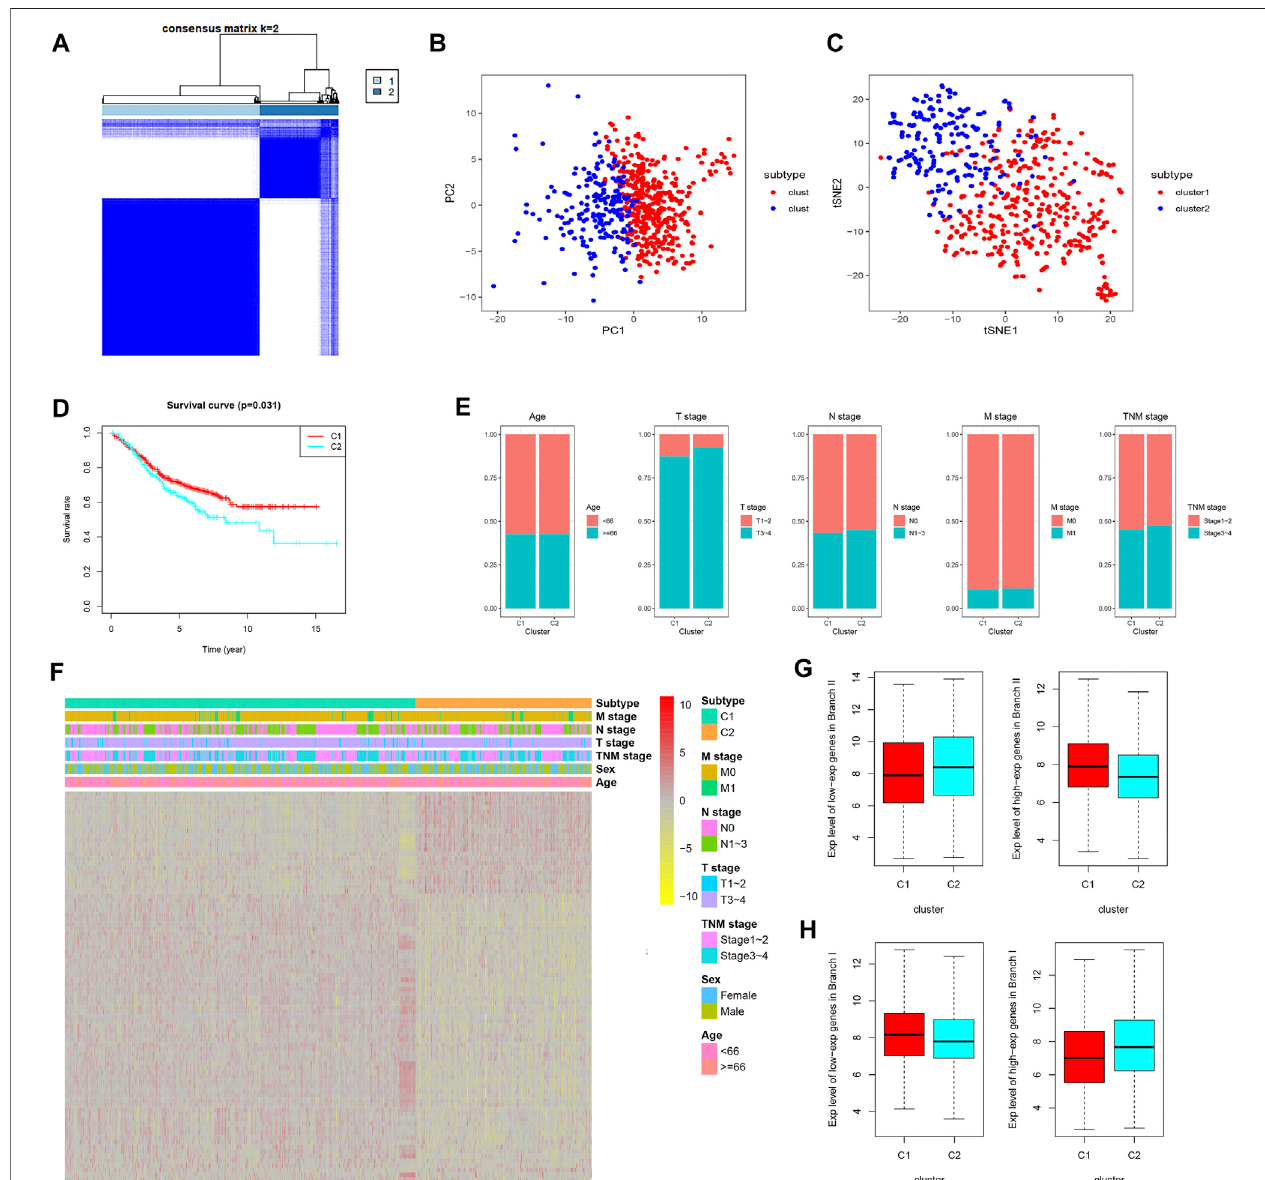
FIGURE3| CDRG-basedconsensus clusteringanalysisofCCpatientsfromtheGSE39582dataset. (A – C) Twomolecularsubtypes wereidenti fi edataclustering threshold of maxK (cid:1) 2. (B) PCA. (C) tSNE algorithm. (D) Kaplan – Meier analysis between subtype 1 (C1) and subtype 2 (C2). (E) The proportion of clinicopathological variables across the two subtypes. (F) A heat map of differentially expressed CDRGs among the two subtypes. (G) The down/upregulated CDRGs in subtype 1 (C1) showedthesameexpressiontrendasthatinsubsetII(branchII). (H) Thedown/upregulatedCDRGsinsubtype2(C1)showedthesameexpressiontrendasthatin subsetI(branchI).CC,coloncancer;CDRGs,CCdifferentiation-relatedgenes;PCA,principalcomponentanalysis;tSNE,t-distributed stochasticneighborembedding.